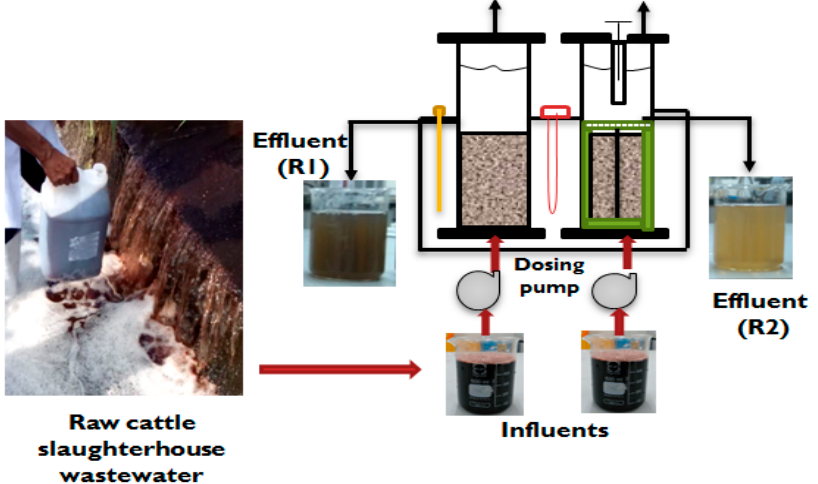
Figure 1. The configuration of the conventional and the modified upflow anaerobic sludge blanket (UASB) reactors setup.